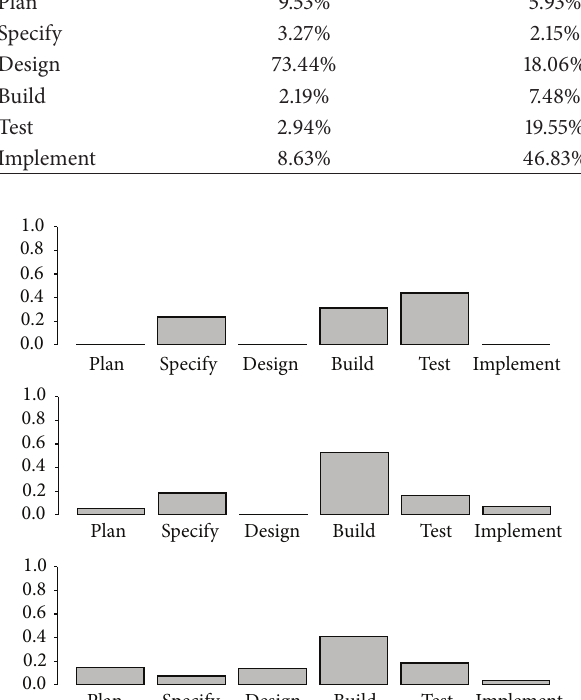
Figure 2: Profile of the mean vectors for the three classes identified.